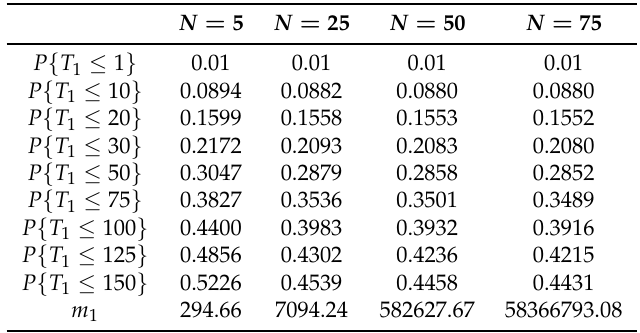
Table 1. Cumulative probabilities for different population